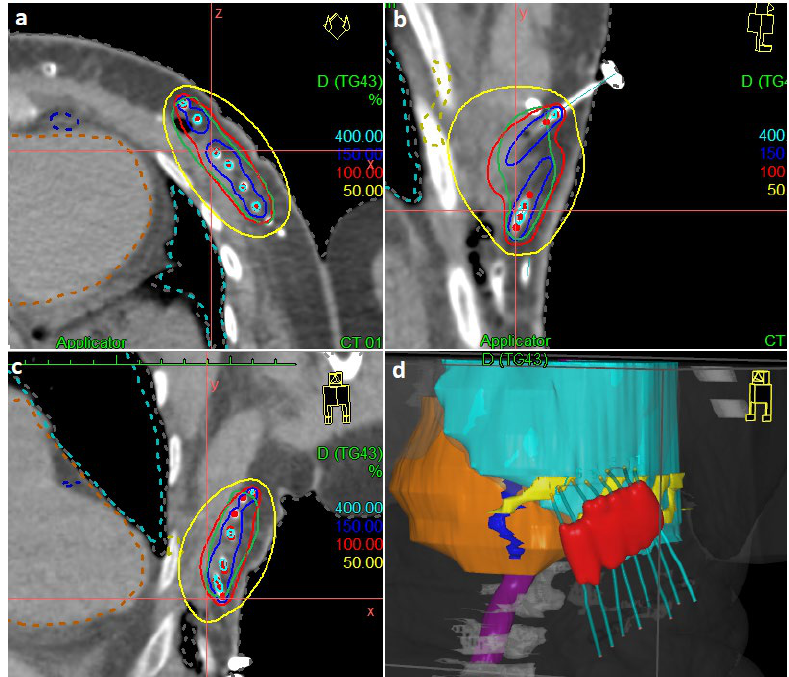
Figure 2. Representative samples of the dose distribution: ( a ): transversa; ( b ): sagittal; ( c ): coronal; ( d ): three-dimensional reconstruction. Green: clinical target volume; yellow: rips; orange: heart; red: reference isodose line.